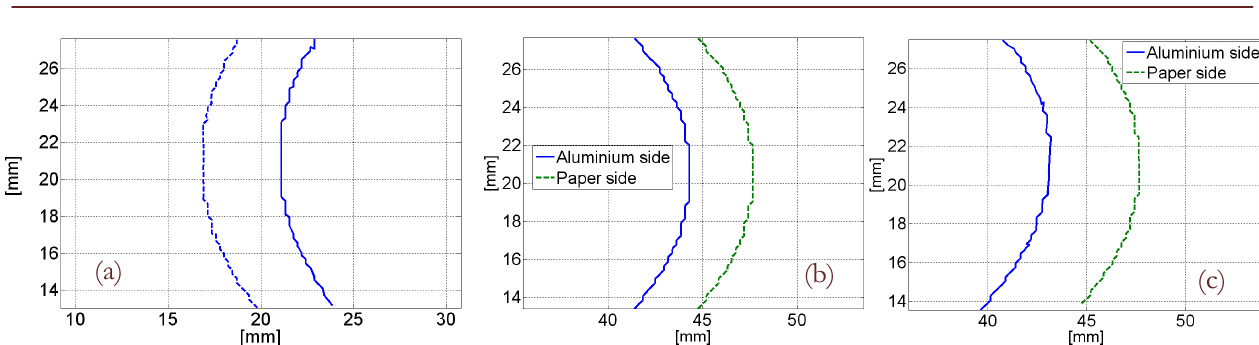
Figure 8: Evolution of the left (a, continuous line: reference image 7; a, dashed line: image 22 ) and of the right (b: reference image 7, c: image 40) boundary between the aluminium laminate and the paperboard composite during the tensile test; in (b) and (c), two reference lines close to the interface where fracture develops (one on the paper side, one on the aluminium side) are separately monitored.